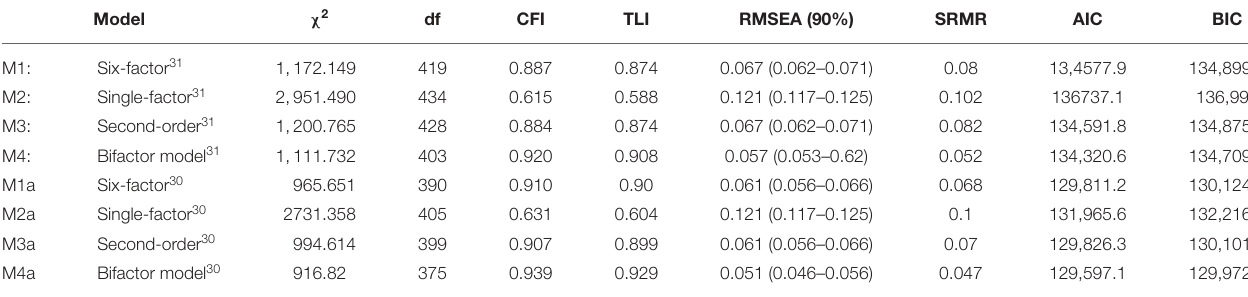
TABLE 2 | Goodness-of-fit indices of the models in comparison. Model